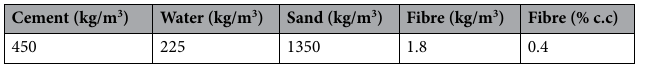
Table 3. Composition of composite mix.